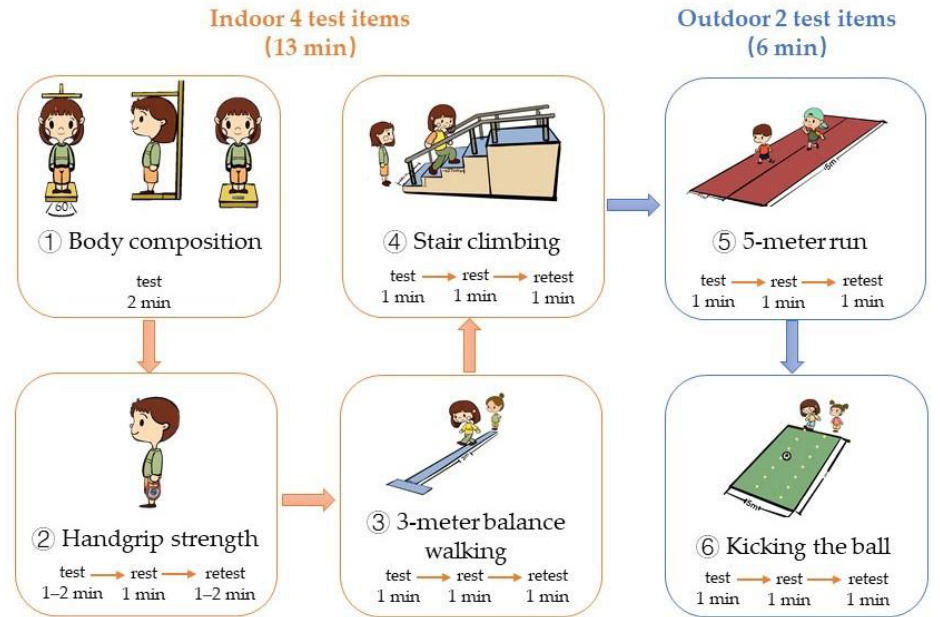
Figure 2. Process of Field-based physical fitness text for children aged 2 – 3 years old.